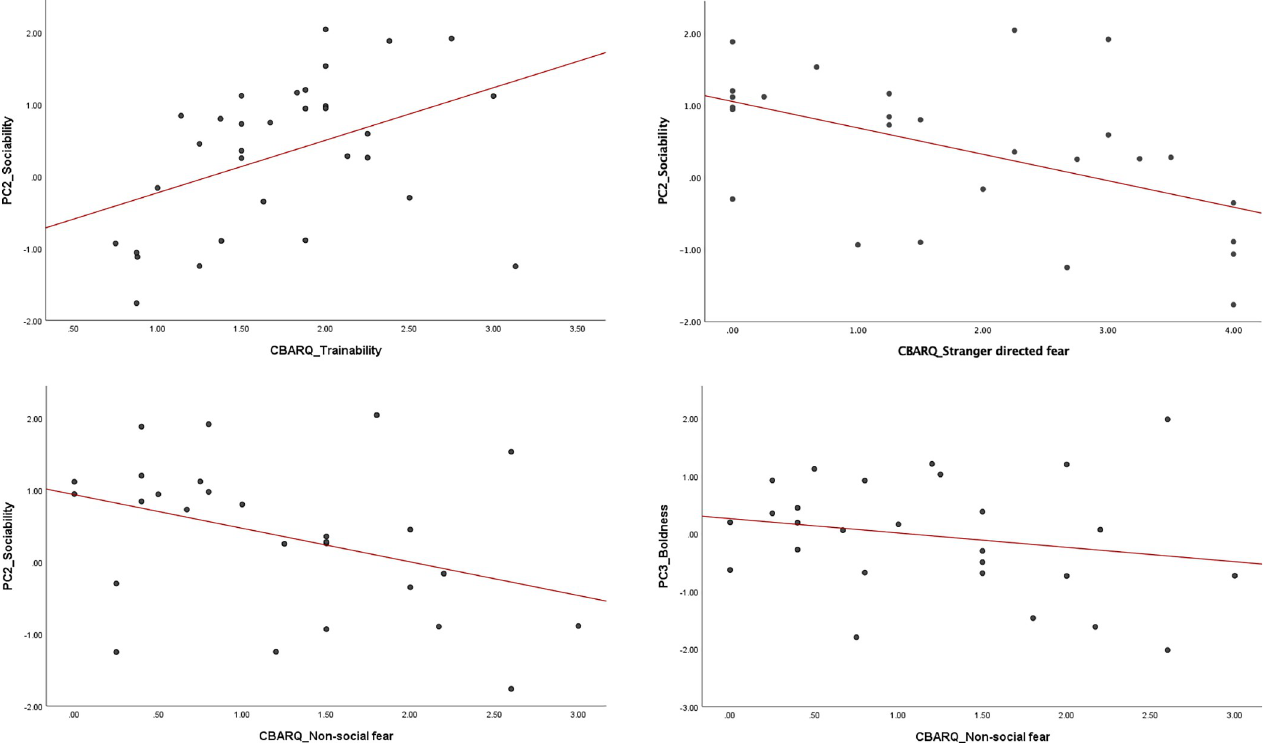
Fig 7. Relationship between pre- and post-adoption behavior. Scatterplot between PC2_sociability, extracted from the analysis of the in-kennel assessment variables, and the C-BARQ subscale trainability (a) stranger-directed fear (b) and non-social fear (c), and between PC3_boldness and CBARQ subscale non- social fear (d). Regression line represented in